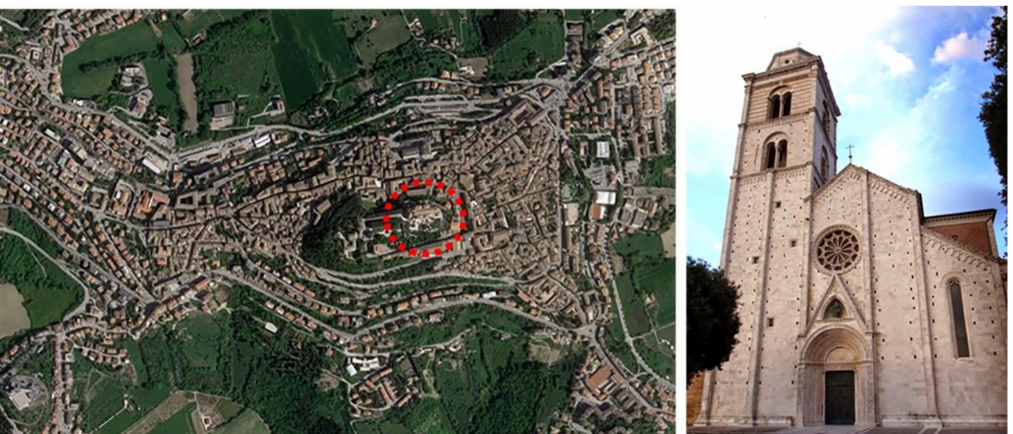
Figure 1. Metropolitan Cathedral of Fermo location (Marche, Central Italy).